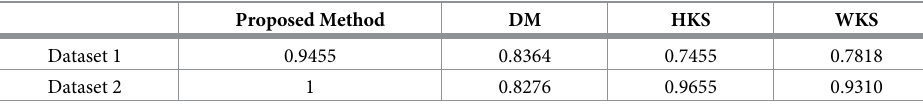
Table 1. ROC AUC for predictions of treatment